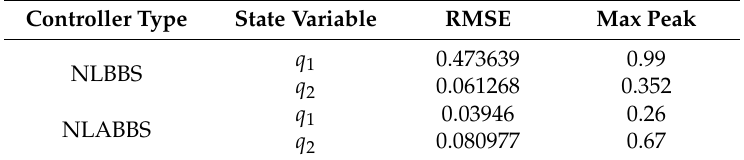
Figure 8. Dynamic Responses of the ( a ) cart displacement, ( b ) ball angular position, and ( c ) disturbance estimation with the two controllers under disturbance.